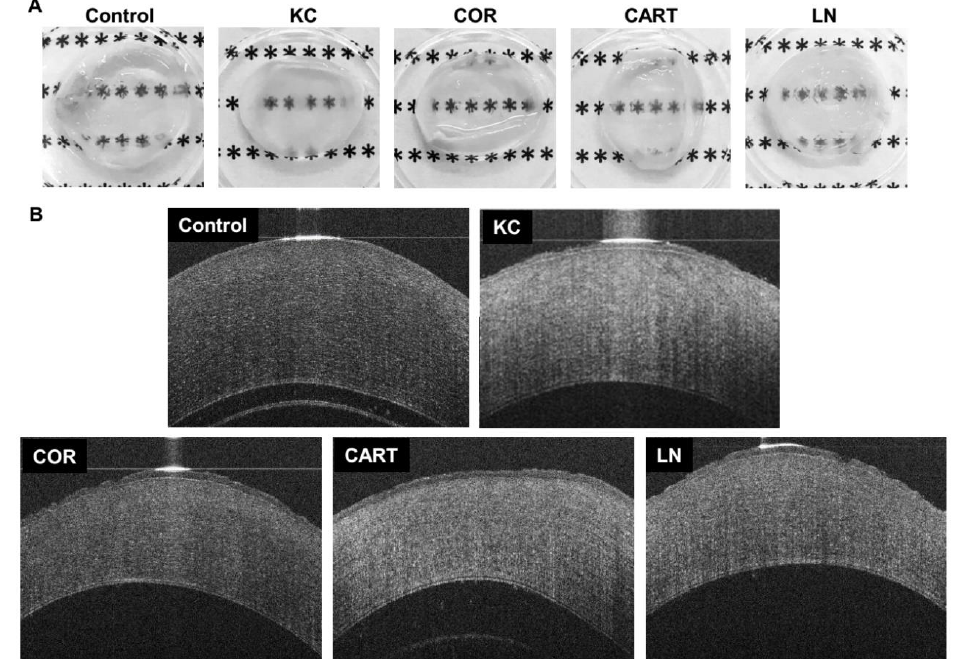
Figure 2. Gross observation and cornea Optical coherent tomography (OCT) before and after TDP treatment. ( A ) gross pictures of corneas with different treatments dissected immediately following tissue culture, and ( B ) OCT images of control corneas, corneas with chondroitinase digestion (KC) and corneas (COR) from the eyes, cartilage (CART), and lymph node (LN) TDP treatments. The cornea extracellular matrix ultrastructure significantly changed with TDP treatment (Figure 3).